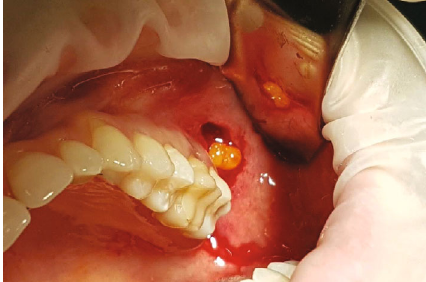
Figure 4: Extension of the incision: from the distal caries of the second molar to the mesial caries of the fi rst molar.